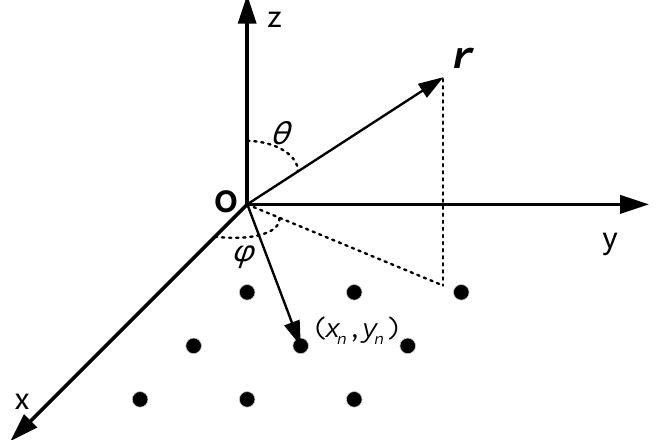
Figure 1. A planar phased array consisting of N elements positioned on the xy -plane. The power pattern of the array